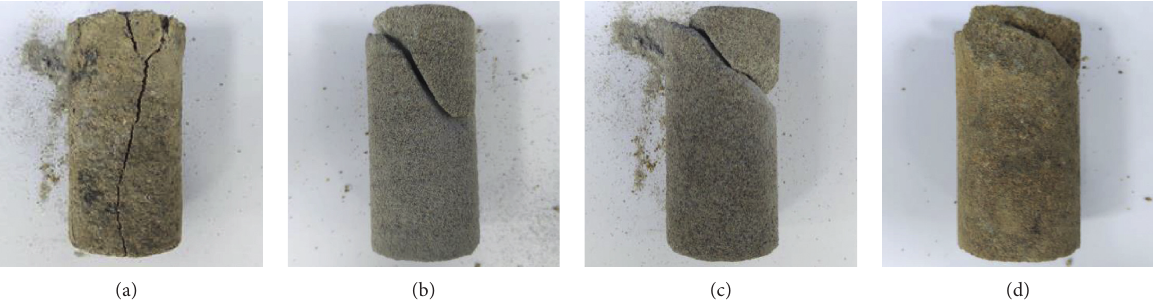
Figure 4: Failure surfaces of sandstone samples under different confining pressures. (a) 4MPa, (b) 6MPa, (c) 8MPa, (d) 10MPa.